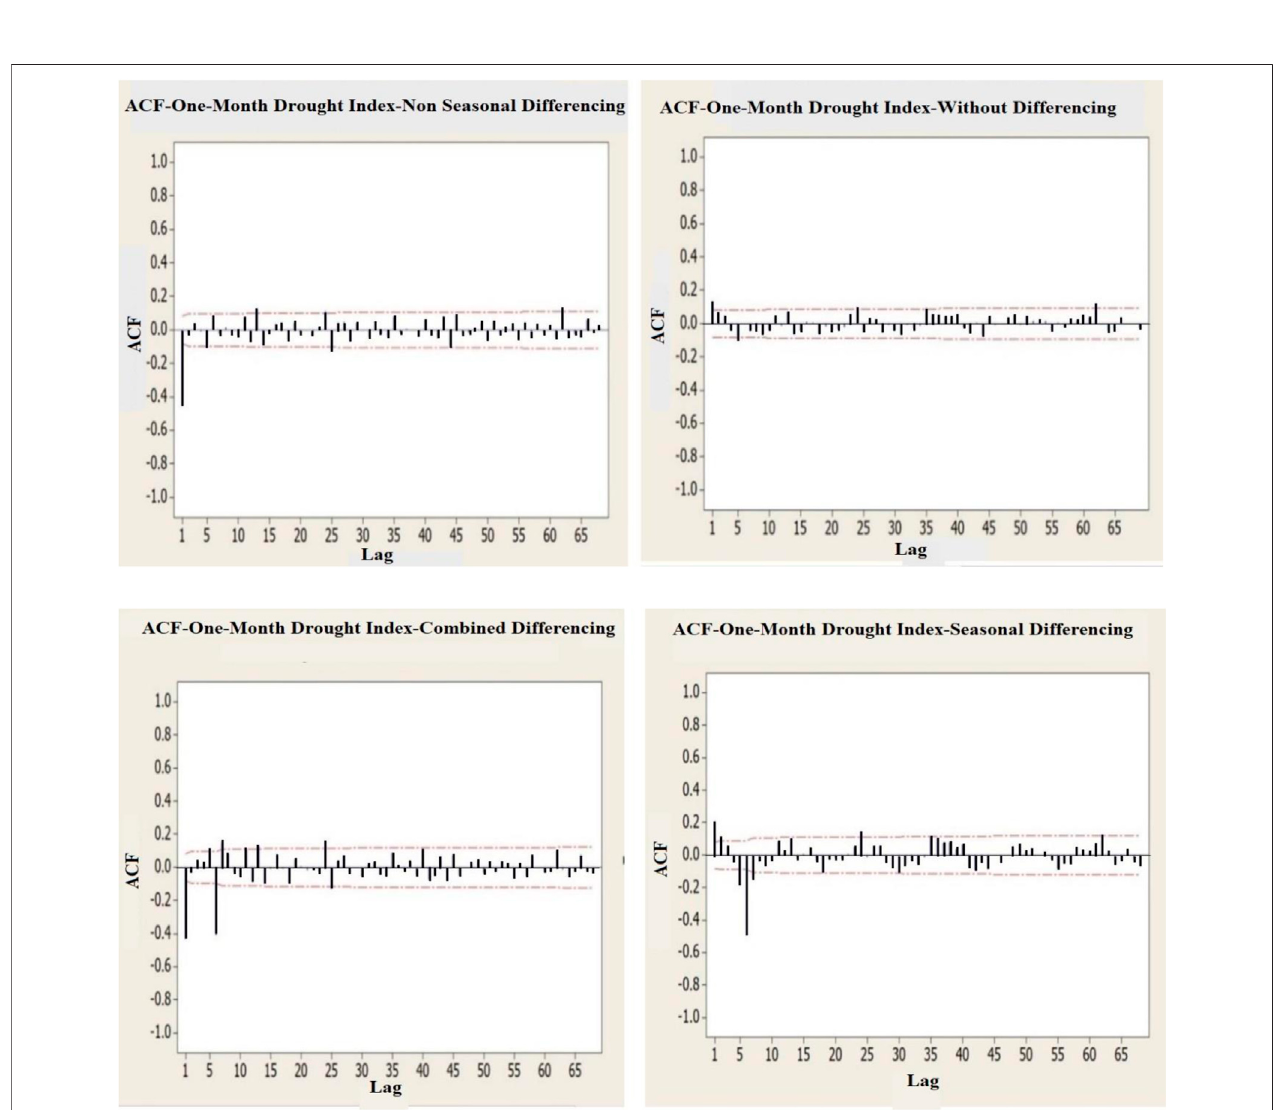
FIGURE 5 | Autocorrelation diagrams of different states of one-month drought index time series.